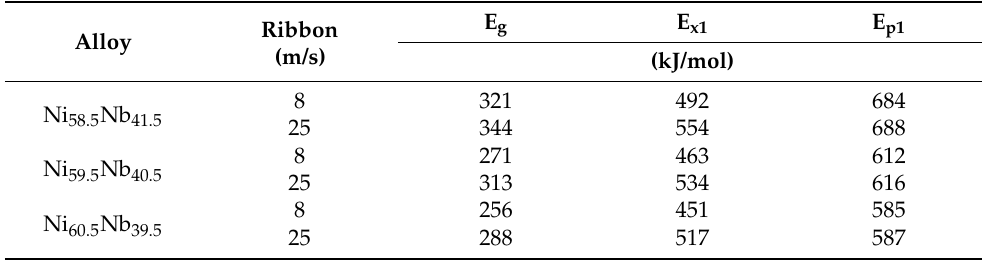
Table 4. Activation energies E g , E x1, and E p1 for 8 and 25 m/s cast ribbons for the Ni 58.5 Nb 41.5